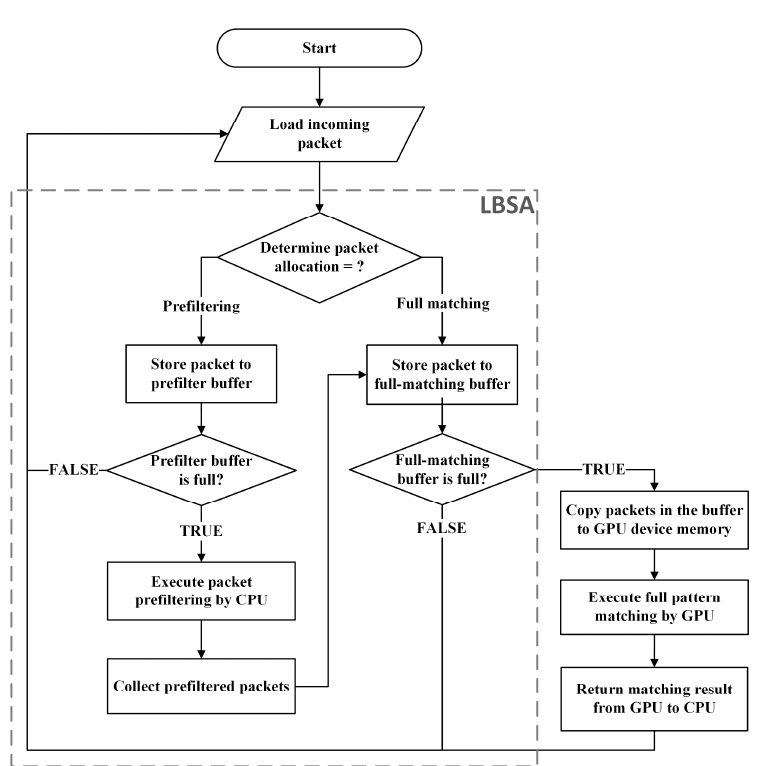
Figure 3. LHPMA overall procedure.